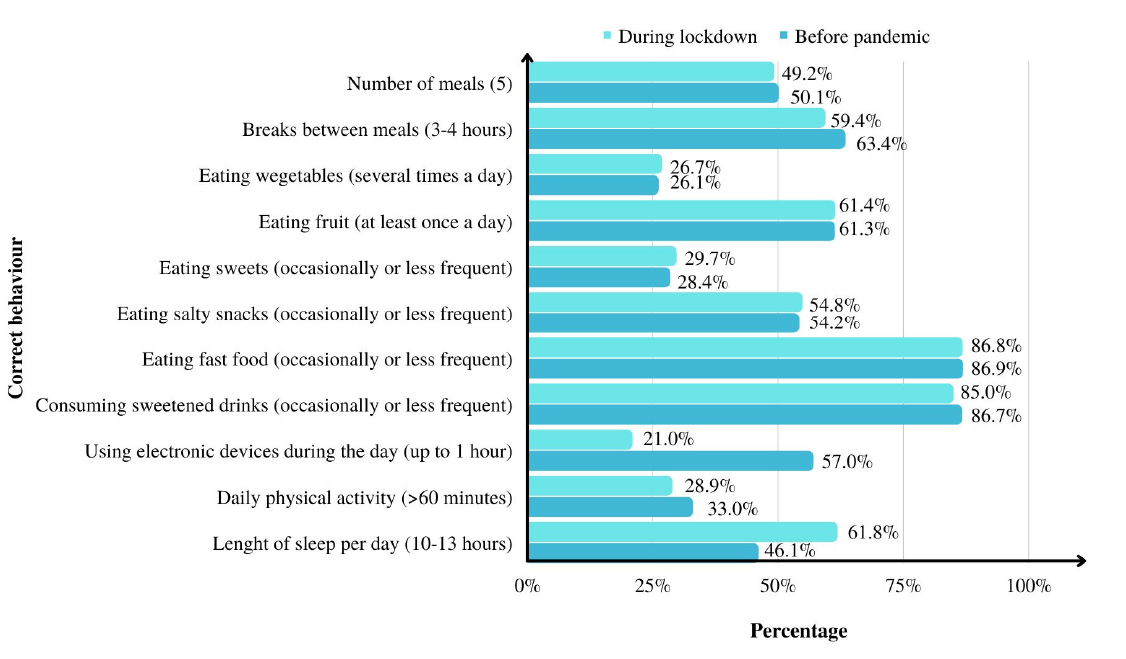
Figure 1. Percentage of parents’ correct behaviour.